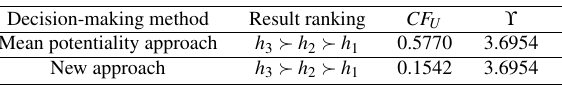
Table 13: The comparison results of the substantial uncertainty factors of overall uncertainty Decision-making method Result ranking CF U Mean potentiality approach